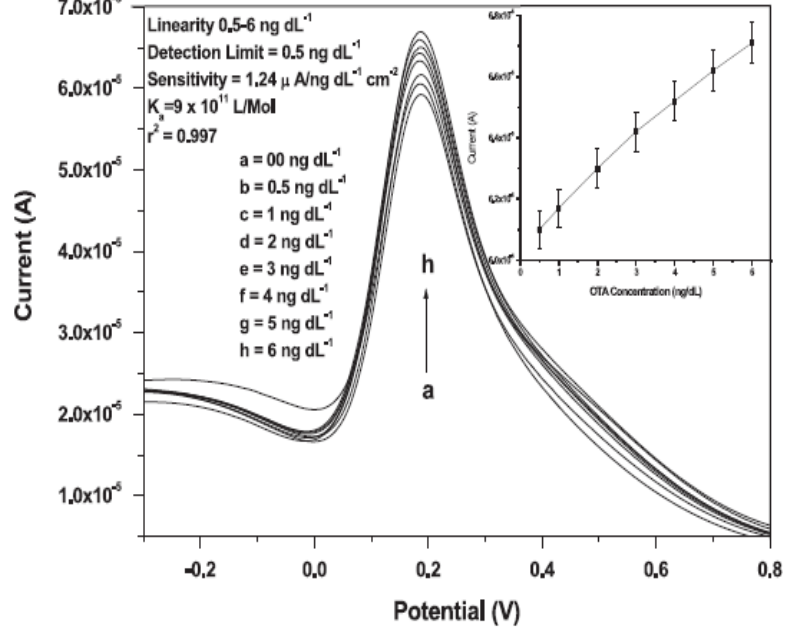
Figure 6. Electrochemical response studies of the BSA/r-IgGs/nanoCeO immunoelectrode as a function of OTA using DPV, inset: calibration curve between the magnitude of current (A) and OTA concentration (ng dL −1 )